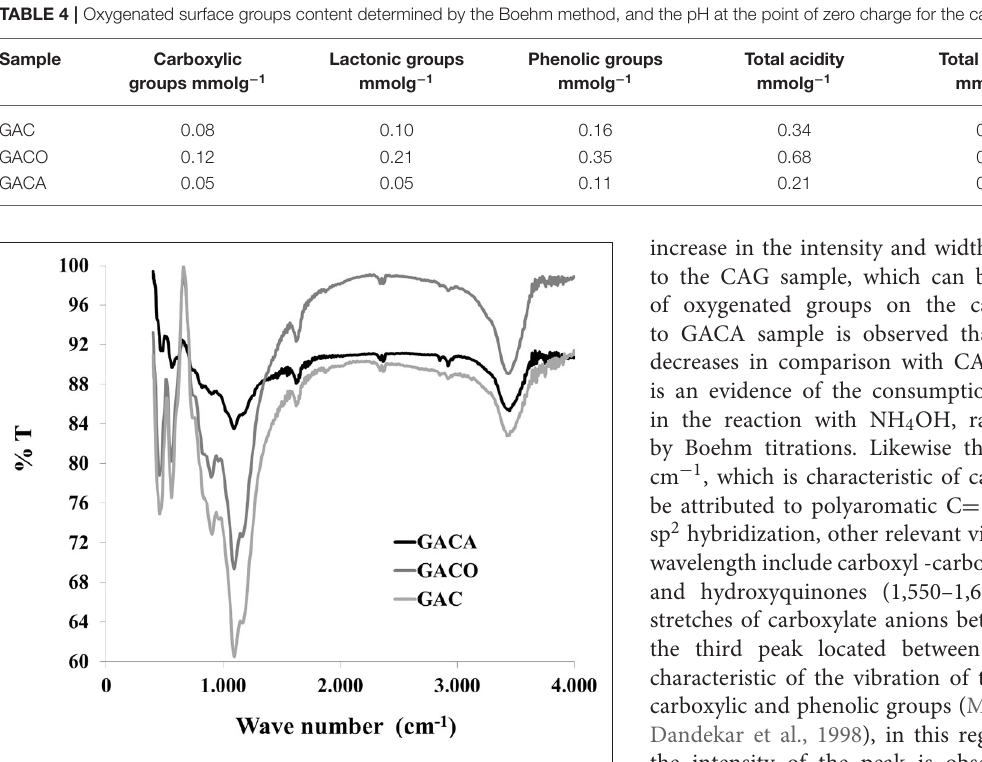
FIGURE 3 | FTIR spectra for carbonaceous